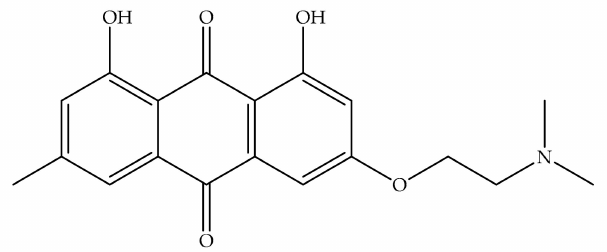
Figure 7. Chemical structure of compound 1